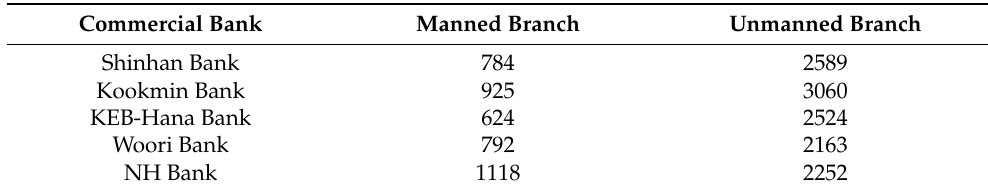
Table 1. Number of manned vs. unmanned branches of South Korea’s five major commercial banks (November 2021).